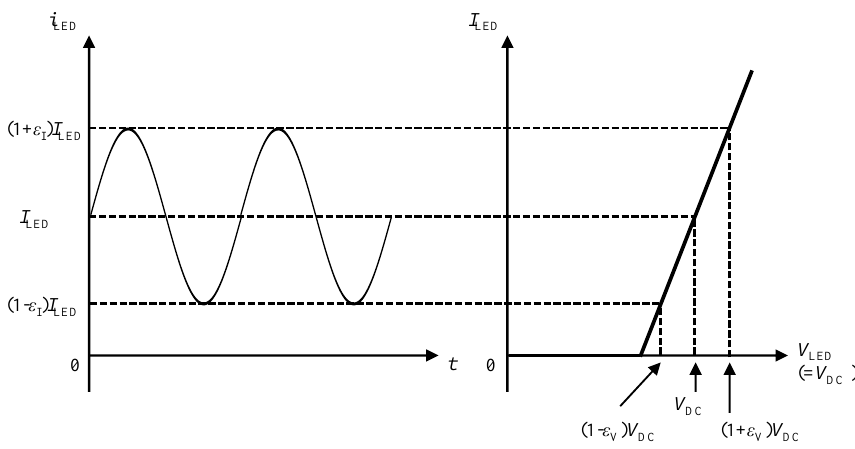
Figure 6. Relationship between the LED current and LED voltage